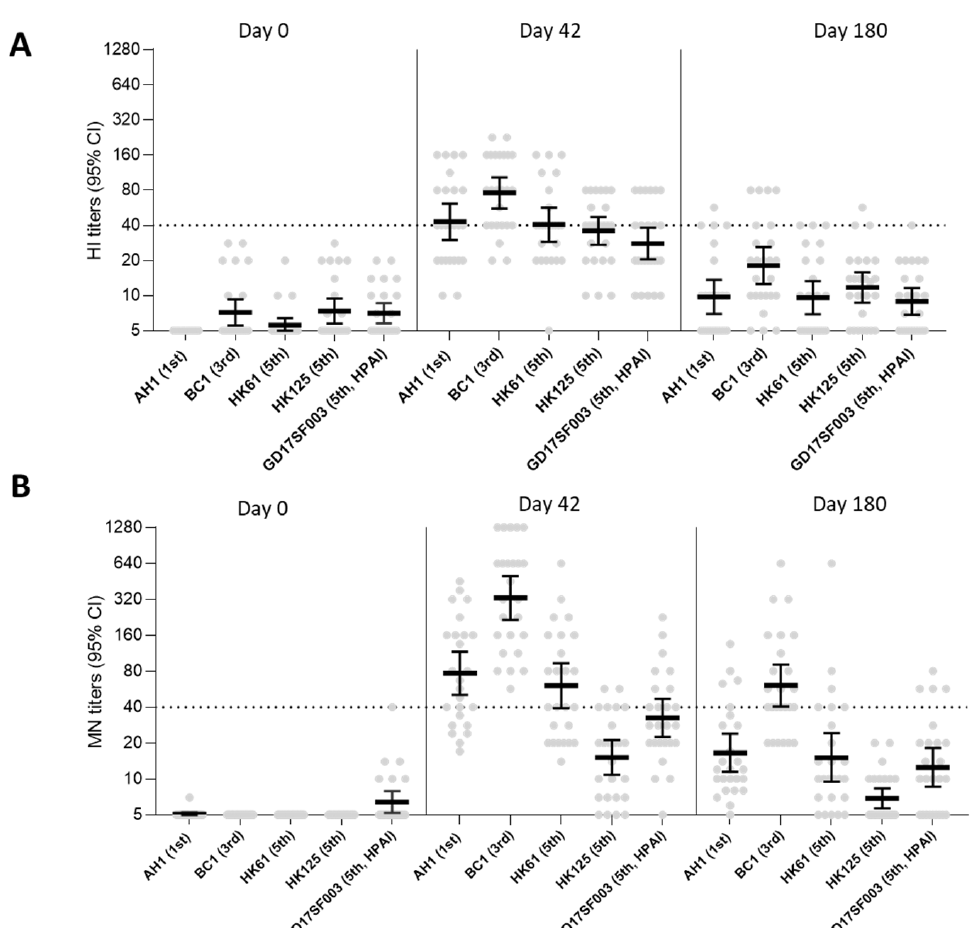
Figure 3. A(H7N9) HI and MN antibody responses at 0, 42, and 180 days post-1st dose following vaccination with 2.8 µ g HA/dose + AS03 A in vaccine group 1. ( A ) HI antibody responses and ( B ) MN antibody responses to homologous and heterologous A(H7N9) viruses following vaccination. AH1: A/Anhui/1/2013; BC1: A/British Columbia/1/2015; HK61: A/Hong Kong/61/2016, HK125: A/Hong Kong/125/2017; GD17SF003: A/Guangdong/17SF003/2016. Dots in the scatter plots represents individual titers. GMTs with 95% confidence interval (CI) were shown. Dashed line denotes a titer of 40.